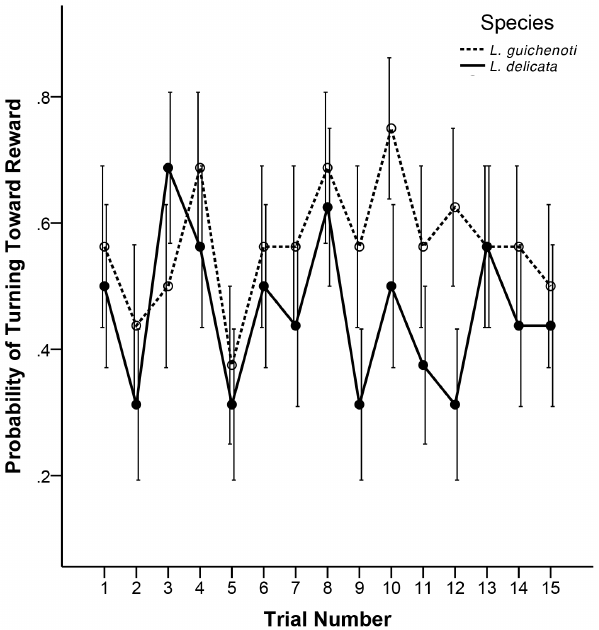
Figure 4. Turning probability. Probability of L. delicata (solid line) and L. guichenoti (broken line) turning towards the food reward after entering the decision point of a maze in each trial. Error bars represent standard errors for each species in each